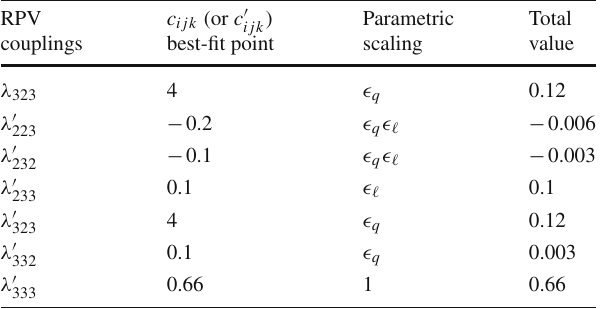
Table 2 The individual χ 2 components evaluated at the best-fit point and compared with the respective SM limits